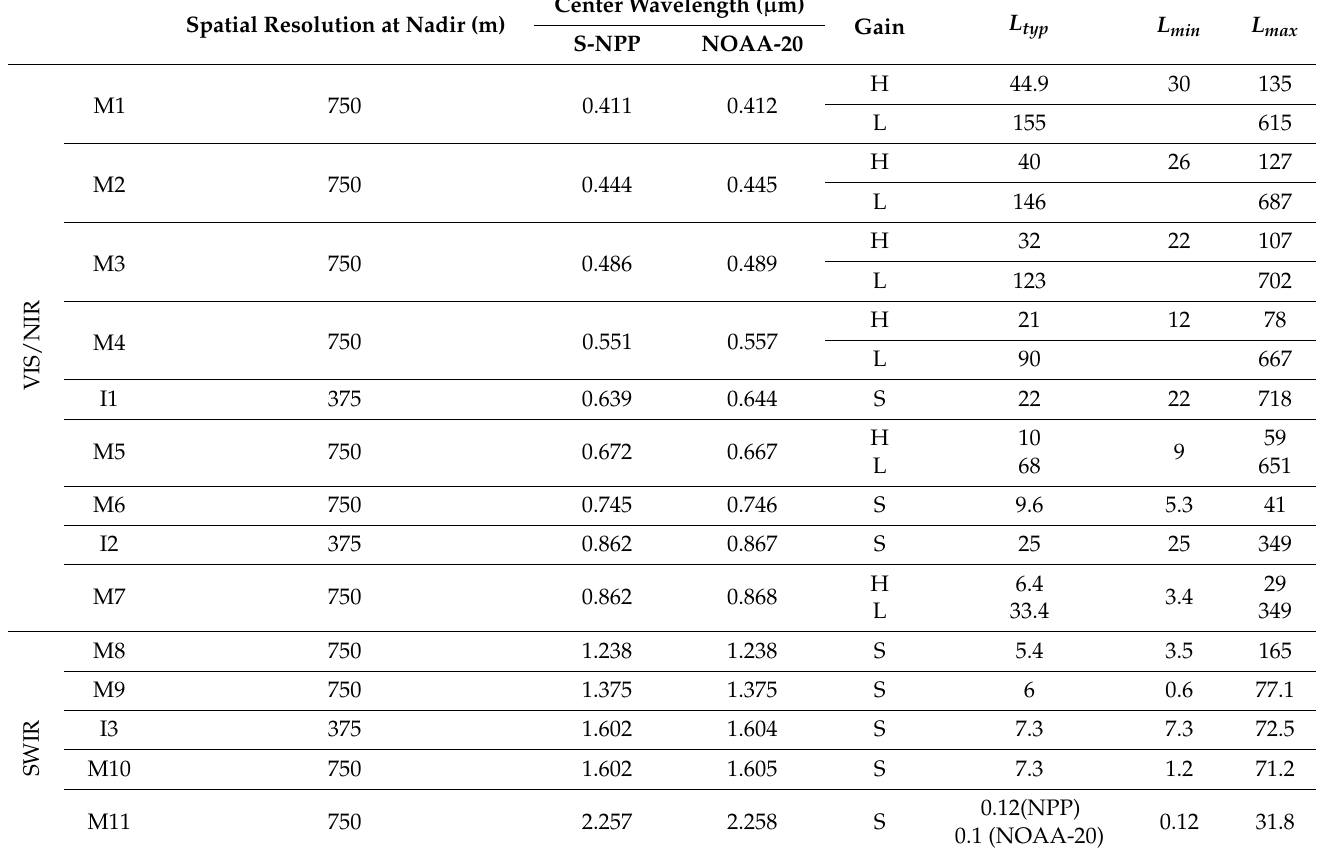
Table 1. Spatial and spectral characteristics of NOAA-20 and S-NPP VIIRS RSBs. The unit of L typ (typical radiance), L min (minimum radiance), and L max (maximum radiance) is W/(m 2 · µ m · sr). M1–M5 and M7 are dual-gain bands: H (high-gain) and L (low-gain) I1–I3, M6, and M8–M11 are single-gain bands